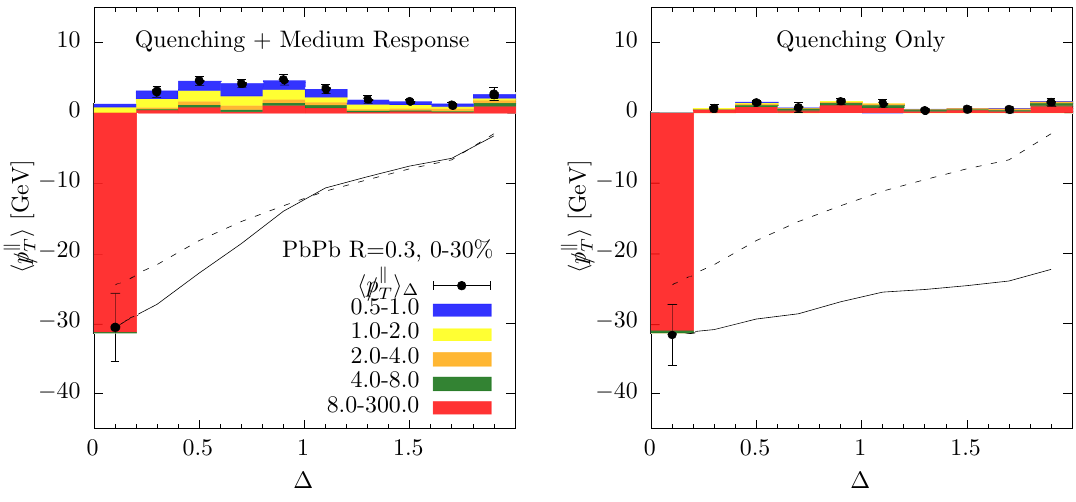
Figure 12 . Results from our calculations of the missing =p k for tracks that are (cid:1) away from the dijet T axis in ( (cid:17); (cid:30) )-space, in PbPb collisions containing a pair of R = 0 : 3 jets satisfying kinematic criteria described in the text. The (cid:12)rst nine bins in (cid:1) are each 0.2 wide, together covering 0 < (cid:1) < 1 : 8. The tenth bin, plotted at (cid:1) = 1 : 9, contains the missing =p k for all the tracks with (cid:1) > 1 : 8. Note T that we limit our analysis to tracks with (cid:17) < 3. In the left panel, we show the results of our full j j calculation, with energy loss calculated within our hybrid model with no momentum broadening, and with particles coming from the backreaction of the medium included. The right panel shows our results if we leave out the particles coming from the backreaction of the medium. In both plots, the solid black points show the net =p k of all charged tracks with (cid:17) < 3 in each (cid:1) bin. The T j j contribution to this net momentum of tracks in di(cid:11)erent momentum bins are codi(cid:12)ed by the colored histograms. In both plots, the solid line shows the cumulative sum of all the =p k in a (cid:1) bin and all T the (cid:1) bins to its left. The black points, the colored histograms, and the solid line are all calculated for 0-30% central PbPb collisions with p s = 2 : 76 ATeV. For comparison, we have repeated the calculation for proton-proton collisions as described by our Pythia tune, and the dashed line in each plot shows the same cumulative sum of =p k for proton-proton collisions that the solid line shows T for PbPb